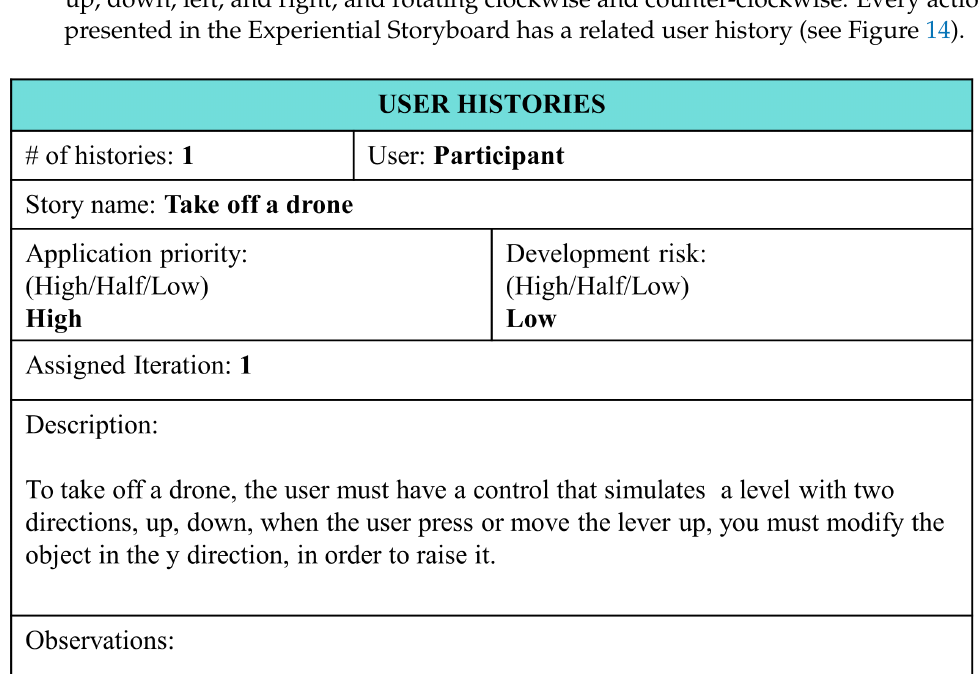
Figure 14. User stories for a drone